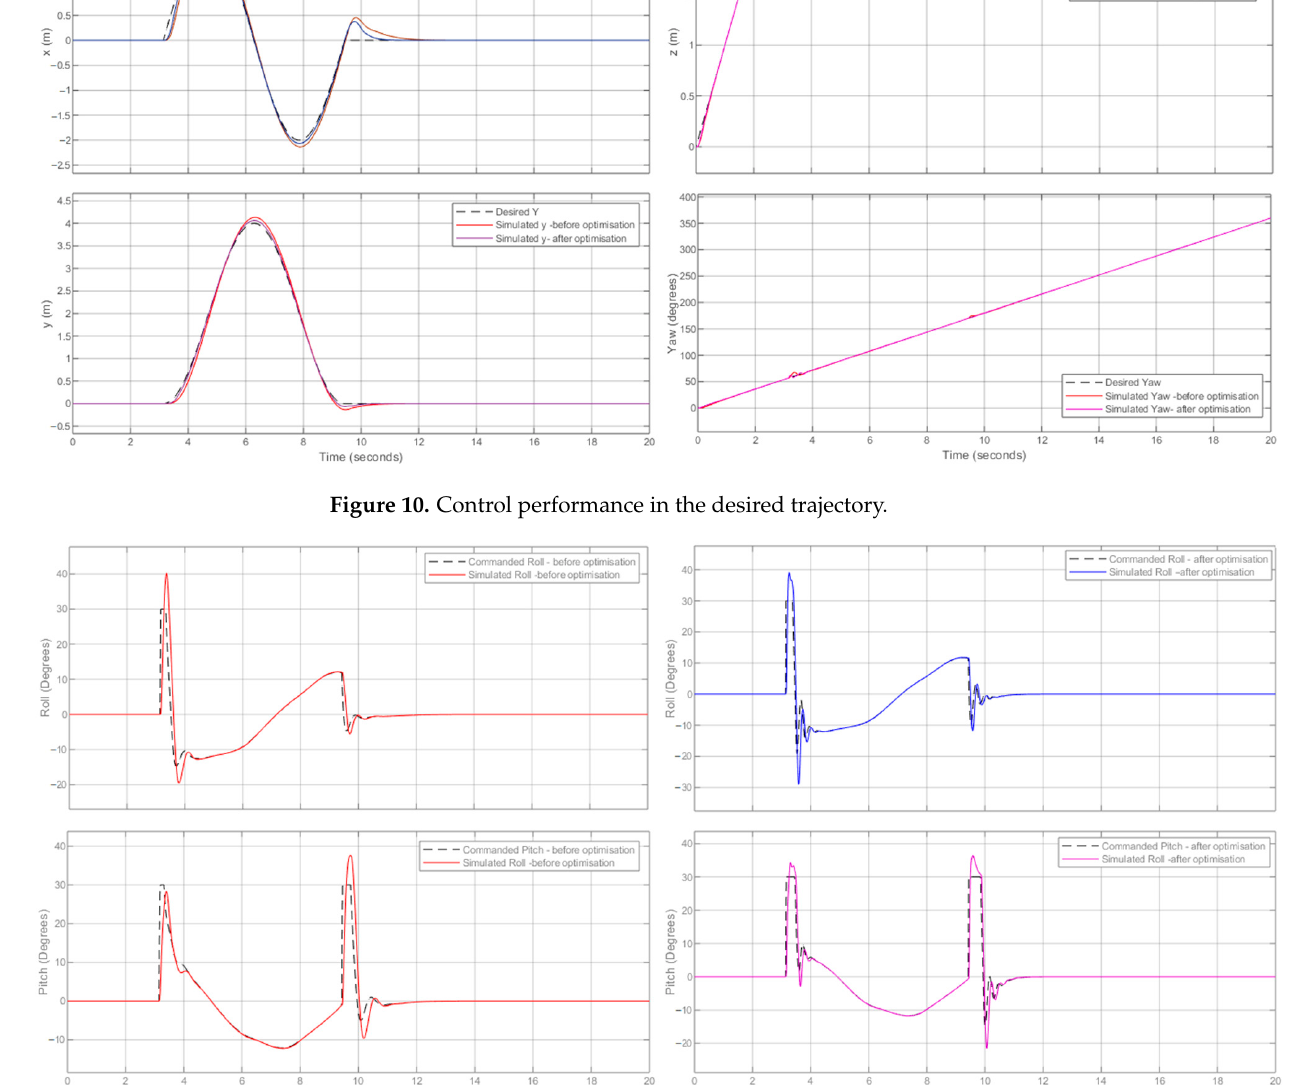
Figure 11. Control performance in roll and pitch.